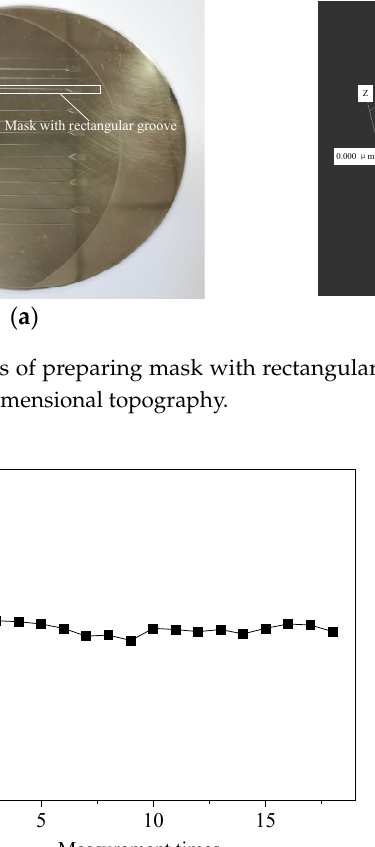
Figure 6. Development results: ( a ) average mask size relative to design size with different develop- ment times; ( b ) local morphology of mask with development time of 720 s.